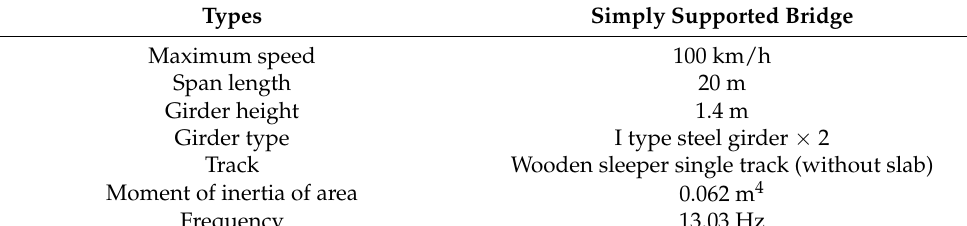
Table 3. Specifications of bridge A.